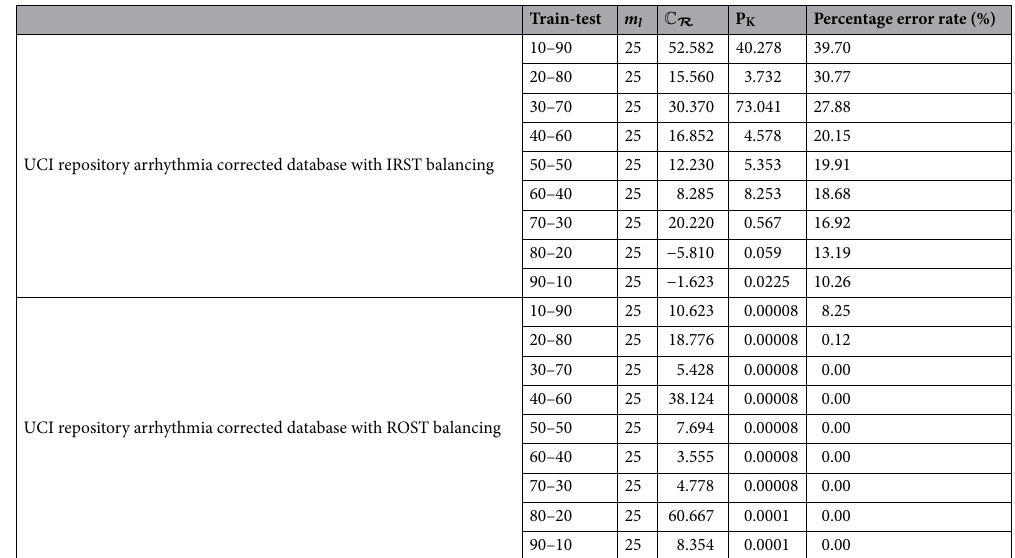
Table 8. The values of the KELM parameters ( C R , P K ) and the feature extraction parameter, m l are also obtained by optimizing GA to achieve minimum error rate. As with increasing training data, error rate reduces, therefore, 90–10 Train-Test ratio provides best result with 10.96% error rate in classifying the UCI repository arrhythmia corrected database when IRST is used for data balancing. It means 5 arrhythmias are misclassified out of 46. Similarly, for 70–30 Train-Test ratio, 16.92% error rate is achieved. While, in the second case, when ROST is utilized for resampling the database, results achieved are excellent. In this, 3185 samples are present in this database with 245 samples of each class. Zero error rate is achieved when training data 30% or more is used. It means with only 30% of training data, zero error rate is achieved on